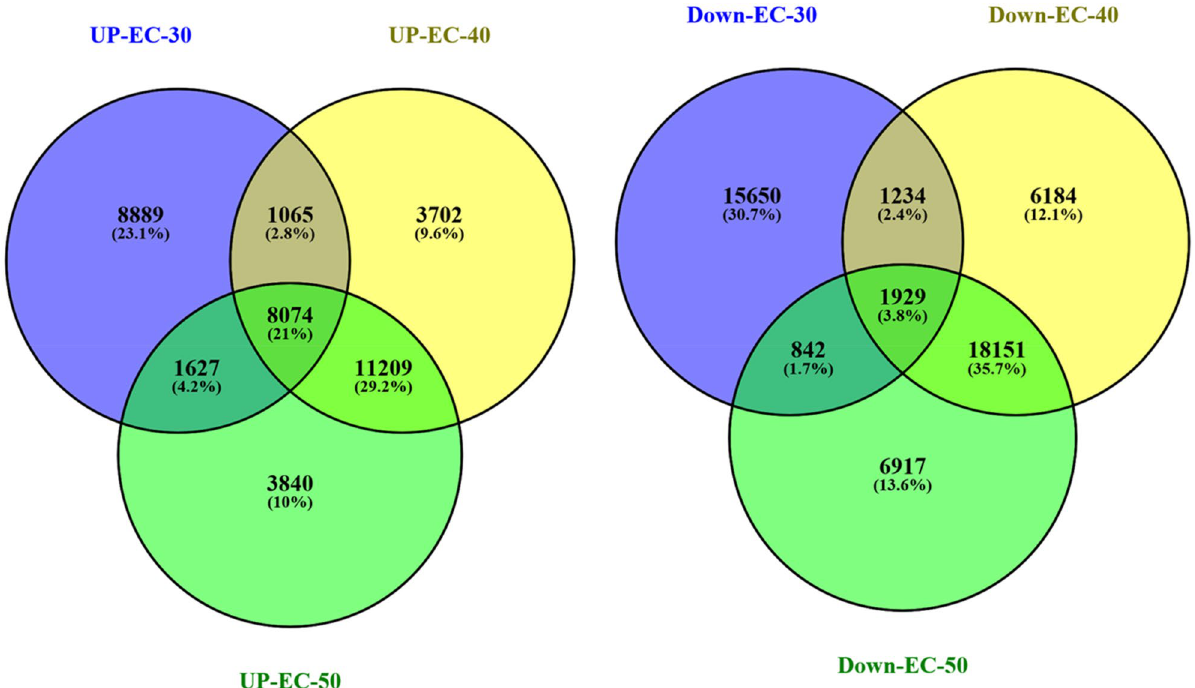
Figure 6. Venn diagram of DEGs at different saline levels in Urochondra setulosa. Constructed using Venny 2.1 (https ://bioin fogp.cnb.csic.es/tools /venny /index